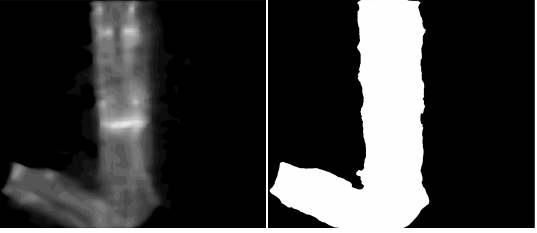
Figure 13. Left: The median filtered image. Right: The generated density